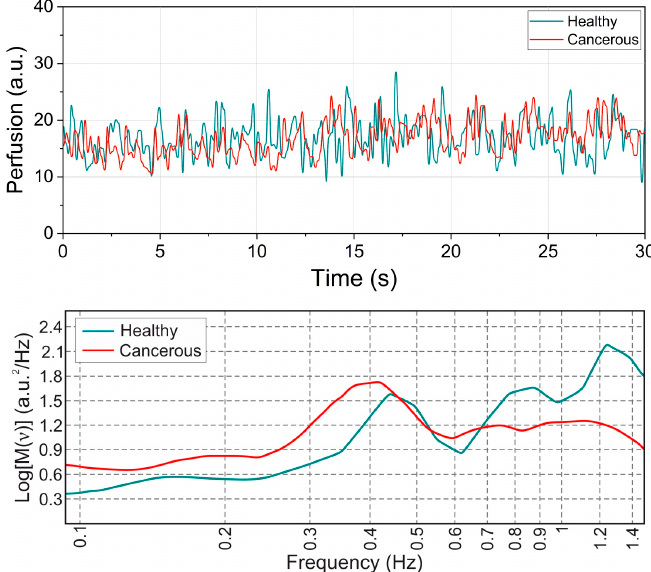
Figure 3. Exemplary blood perfusion records (upper panel) from the intact bile duct wall and the tumour located in the bile duct and the corresponding integrated wavelet spectra (IWS; bottom panel).